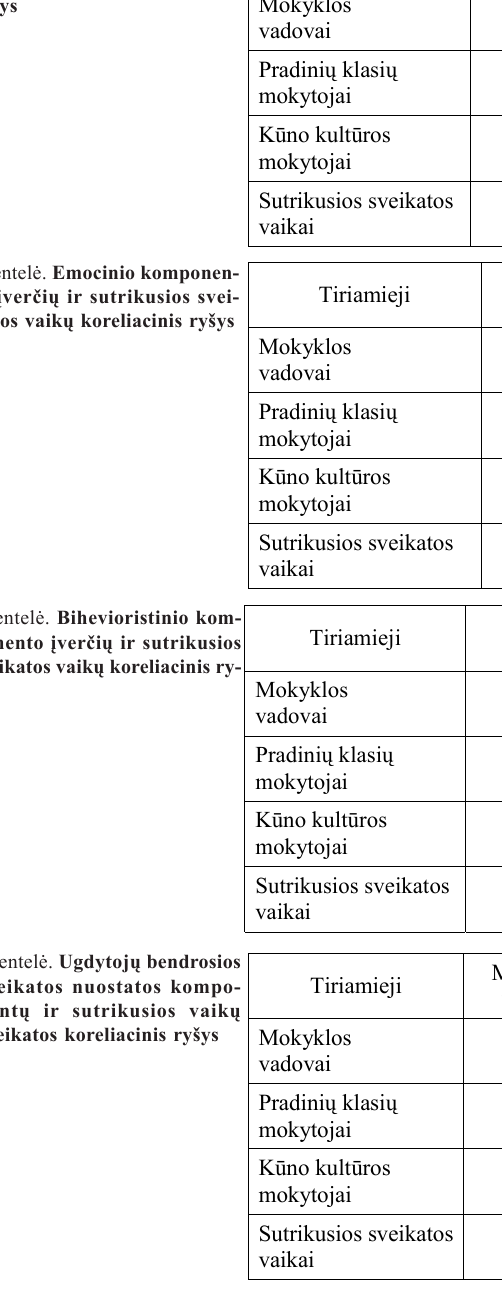
Analizuojant bendrosios sveikatos nuostatos komponent ų sumos ir mokini ų sergamumo kore- liacij ą matyti, kad egzistuoja esminis koreliacinis ry(cid:154)ys (atvirk(cid:154)tin ė priklausomyb ė ) tarp k ū no kult ū - ros mokytoj ų ir mokini ų sergamumo (r = (cid:150)0,467) (5 lent.). Silpnas koreliacinis ry(cid:154)ys (atvirk(cid:154)tin ė priklausomyb ė ) pastebimas tarp mokyklos vadov ų ir mokini ų sergamumo (r = (cid:150)0,382), pradini ų kla- si ų mokytoj ų ir mokini ų sergamumo (r = (cid:150)0,385). Analizuojant koreliacinius ry(cid:154)ius tarp